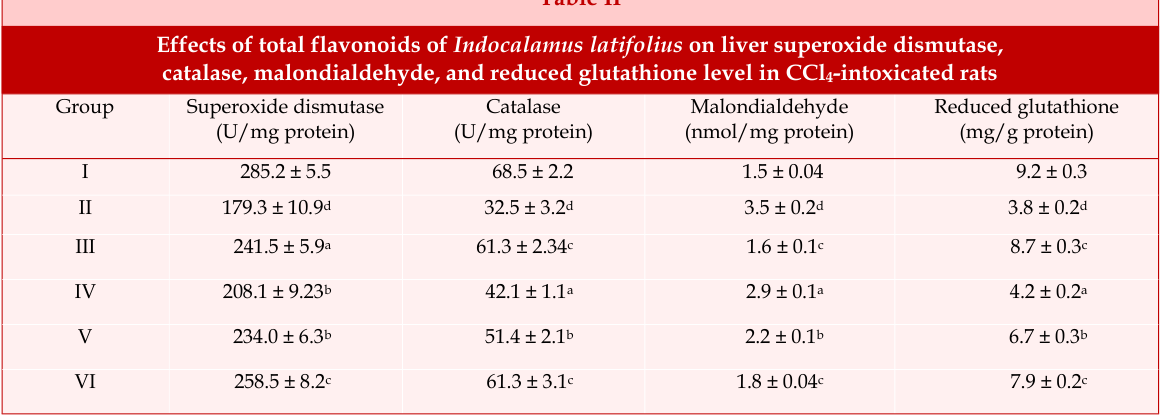
Effects of total flavonoids of Indocalamus latifolius on liver superoxide dismutase, catalase, malondialdehyde, and reduced glutathione level in CCl 4 -intoxicated